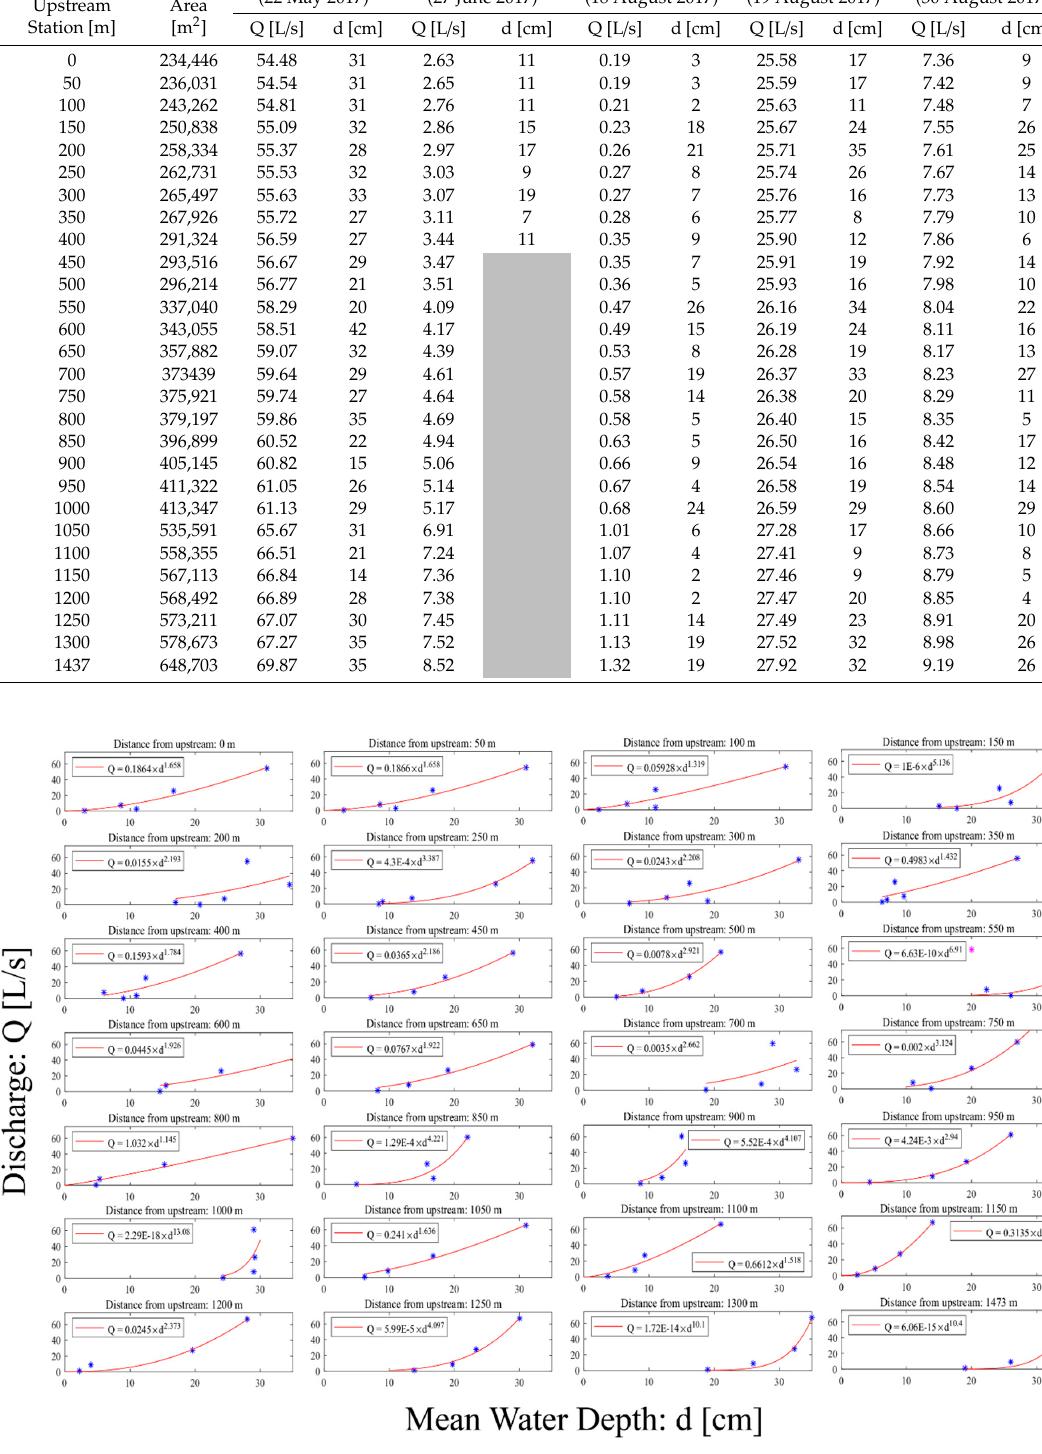
Table 1. Estimated stream discharge values based on measured streamflow data and drainage area (Q), and measured mean water depth (d) for di ff erent flow discharges at 50 m spatial resolution. Distance from Upstream